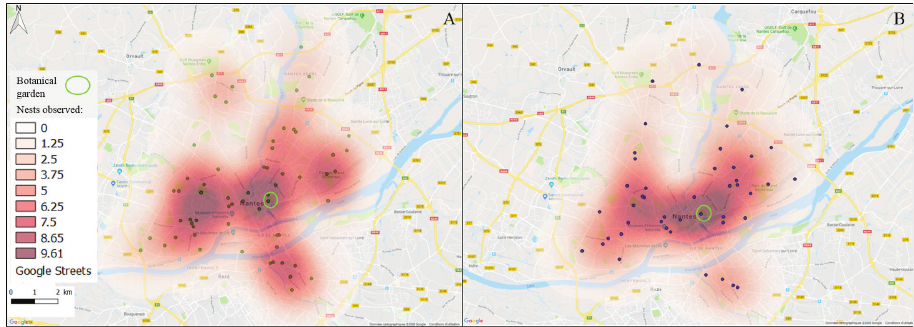
Figure 1. Heatmap of Vespa velutina ’s nests observed in 2015 (A) and in 2016 (B). The green circle shows the location of the botanical garden where plants were collected.